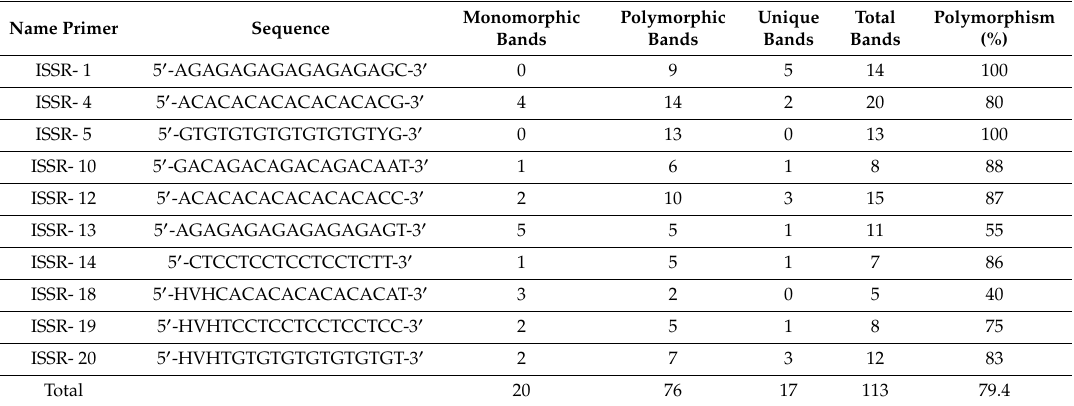
Table 1. The sequence, names of Inter-Simple Sequence Repeat (ISSR) primers, number of polymorphic, monomorphic, unique, total bands, and polymorphism (%) calculated by the analysis of ISSR in the examined Aerva javanica